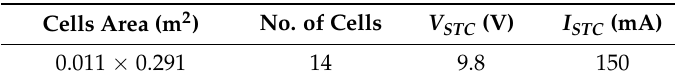
Table 2. Electrical characteristics of DSM.